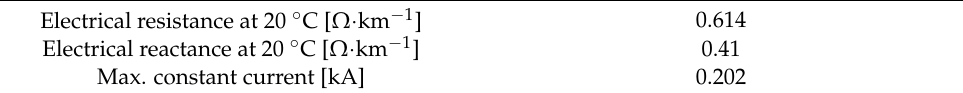
Table 2. Characteristics of 47-AL1/8ST1A aluminum steel reinforced cable [36].